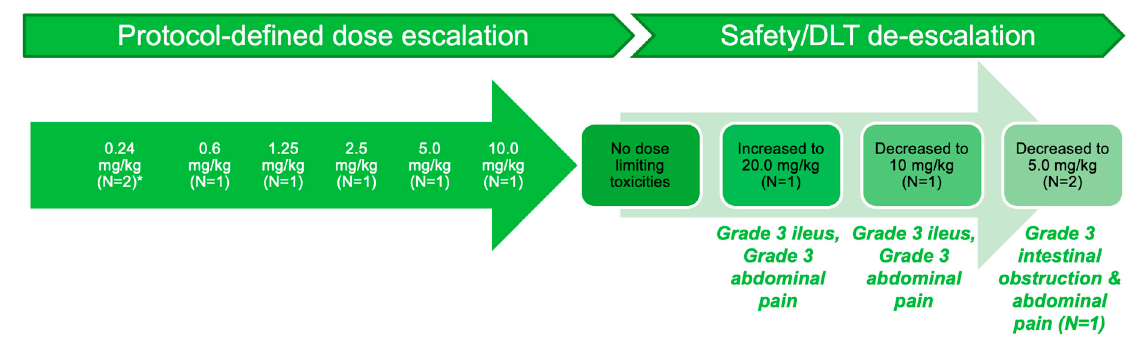
Figure 3. Study Part A: Results of dose-finding assessment. Visual depiction of the number of patients enrolled into pre-specified dose cohorts, and the toxicities upon which the maximum tolerated dose was established. * Two patients were enrolled into the 0.24 mg/kg dose cohort—the first patient experienced intestinal obstruction commencing 5 days after receiving her first dose of Cantrixil; this event was not deemed to be study drug related, but the patient was subsequently withdrawn from the study, and a second patient was enrolled at the same dose level. DLT: dose-limiting toxicity; MTD: maximum tolerated dose.